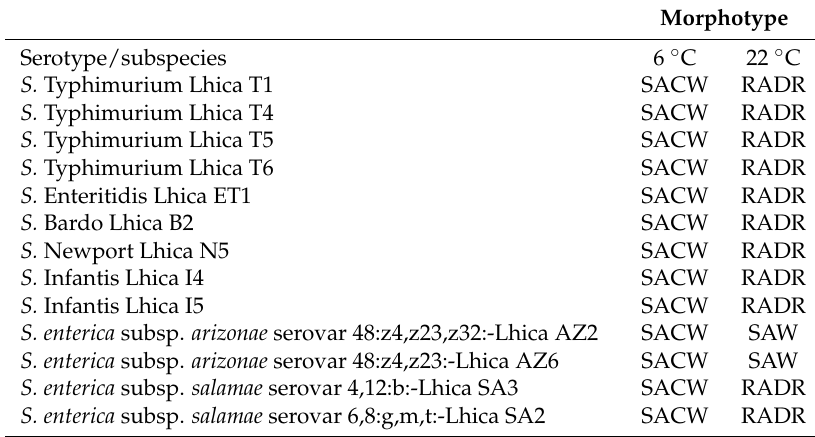
Table 1. Salmonella enterica strains selected for this study and the morphotype produced under different incubation temperatures tested in this study (6 ◦ C and 22 ◦ C).